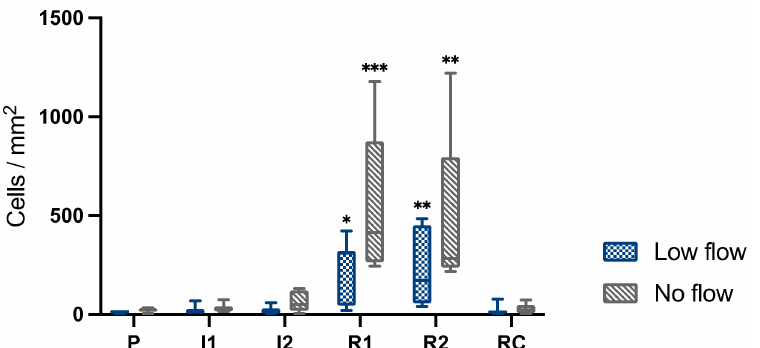
Figure 8. Box-plot diagram of the cleaved caspase-3-positive cells/mm 2 in the mucosa of jejunum subjected to either LF or NF ischaemia at different time points. P, pre-ischaemia; I1, 60 min ischaemia; I2, 120 min ischaemia; R1, 60 min reperfusion; R2, 120 min reperfusion; RC, remote control sample at reperfusion. Significant differences are marked with an asterisk (* p < 0.05; ** p < 0.01; *** p <